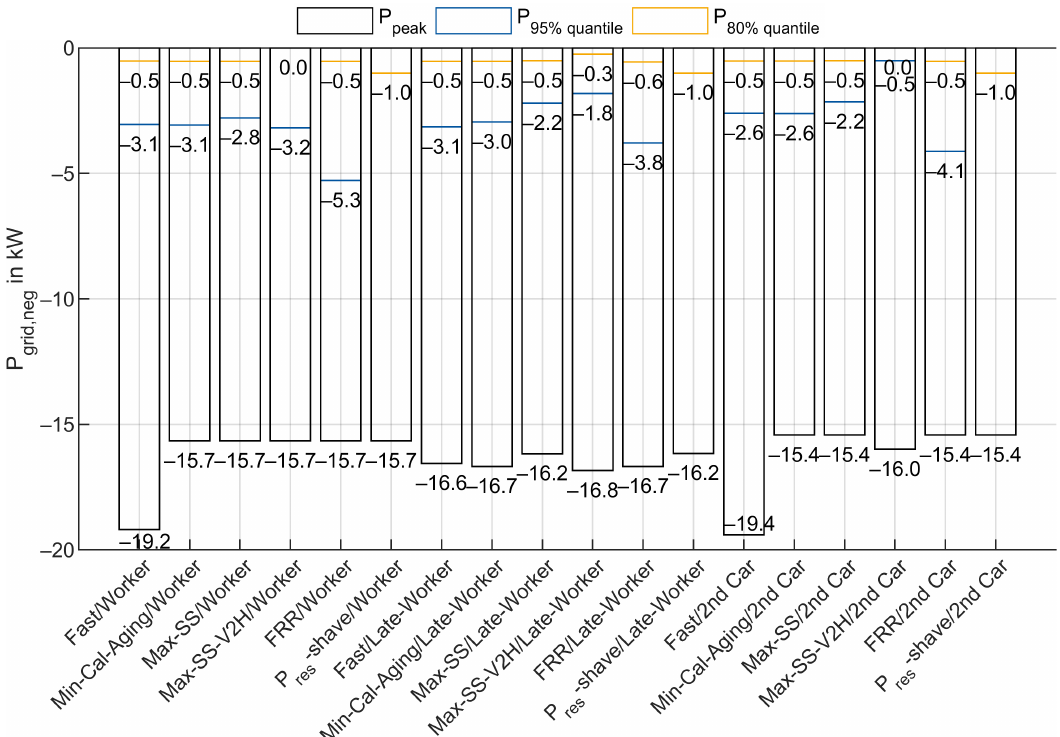
Figure A3. Negative power exchange of the household with the grid for home charging scenario H without SoC V 2 XLimit .